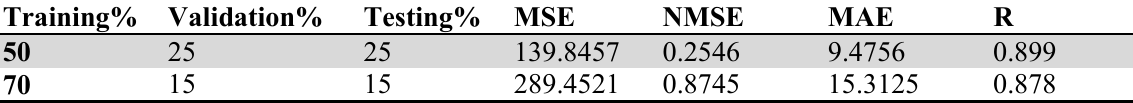
Optimal percentage for training, testing and validating for data used in ANFIS